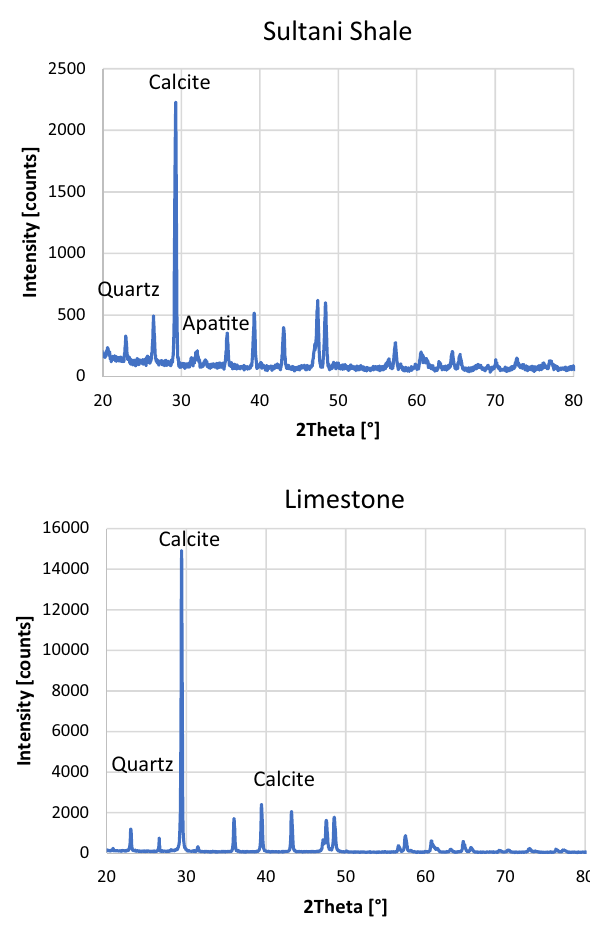
Fig. 2 X-ray diffraction plots of Sultani shale and